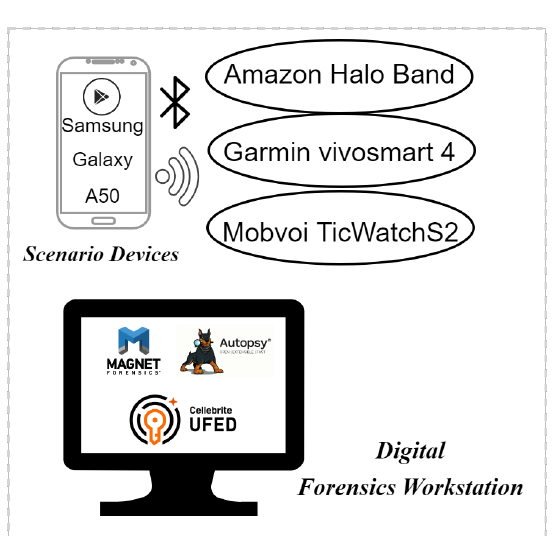
Figure 2. Research Methodology Workflow.